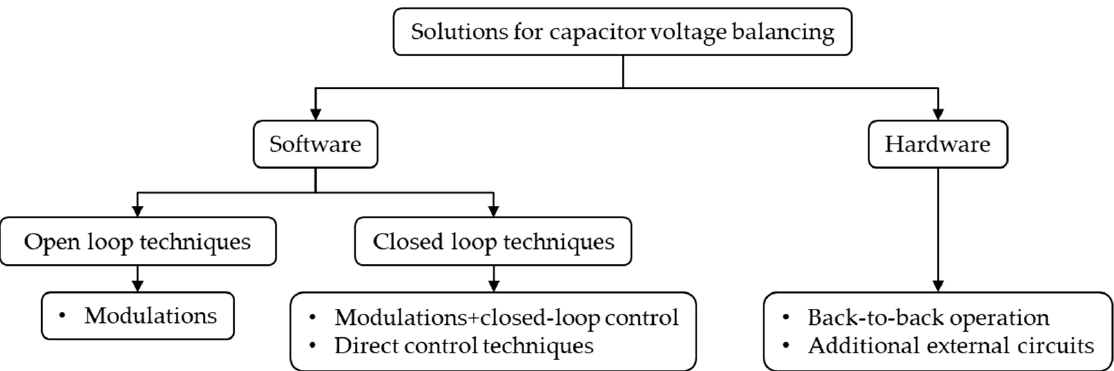
Figure 11. Classification of the solutions for DC-link capacitor voltage balancing.